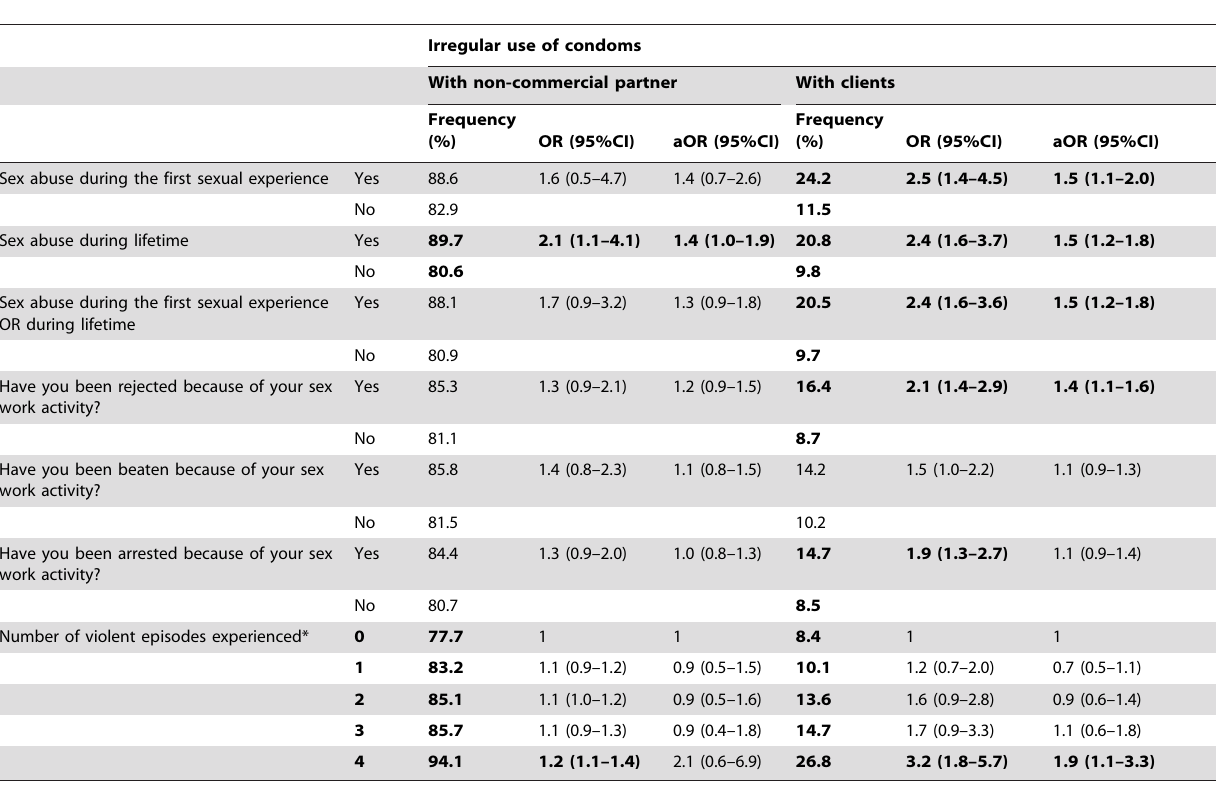
Table 3. Bivariate and multivariate analysis of association between violent experiences and condom use in FSWs recruited in nine cities of Argentina between 2006 and